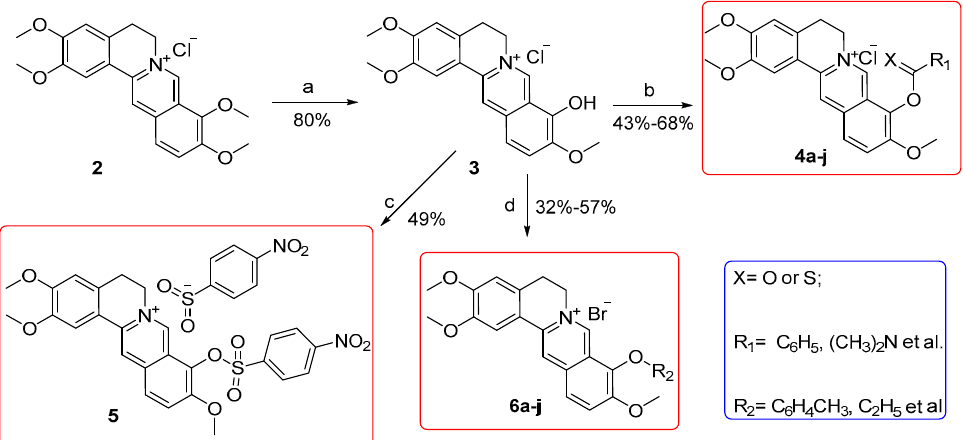
Figure 2. Reagents and conditions: ( a ) 195 − 210 ◦ C, 30 − 40 mmHg, 30 min.; ( b ) RCOCl / RCSCl, triethylamine, CH 3 CN, 65 ◦ C, 3 − 8 h; ( c ) 4-Nitrobenzenesulfonyl chloride, triethylamine, CH 3 CN, 65 ◦ C